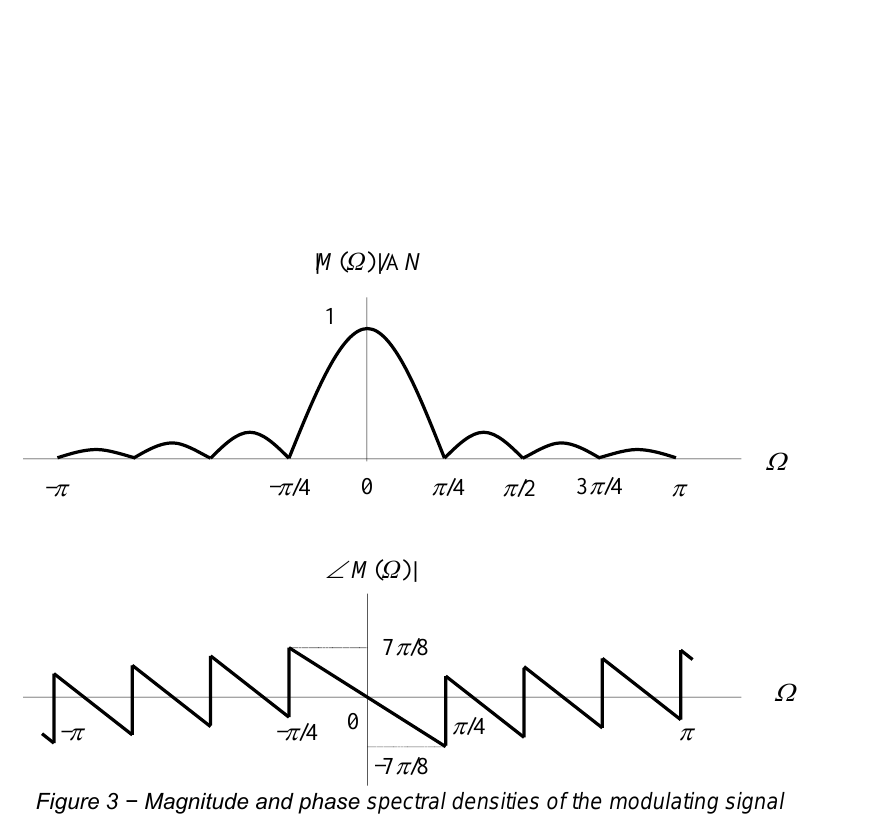
Figure 3 − Magnitude and phase spectral densities of the modulating signal Рис. 3 – Спектральная плотность колебаний и фазы модулирующего сигнала Слика 3 – Спектрална густина магнитуде и фазе модулишућег